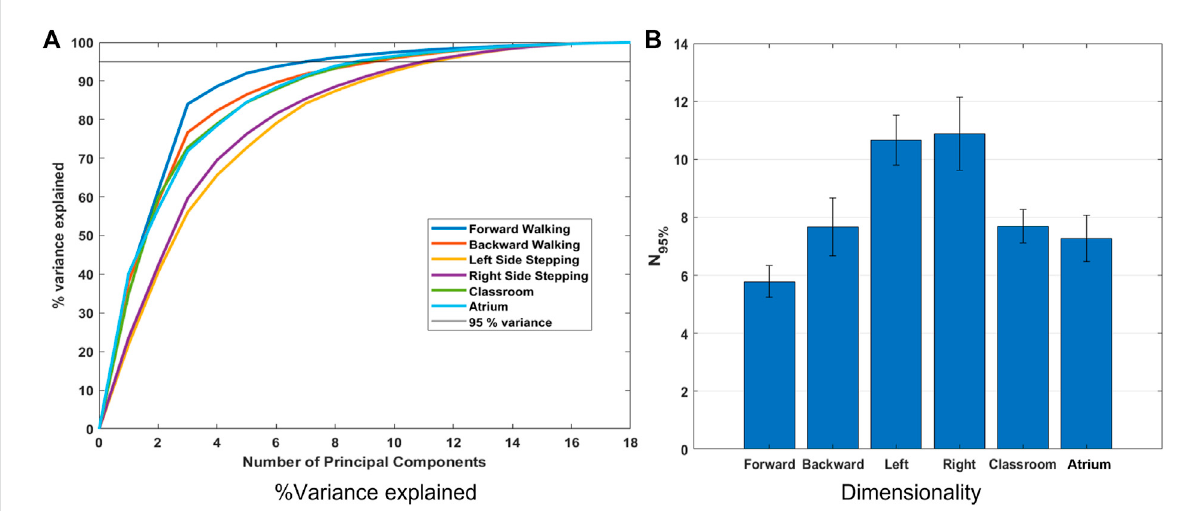
activities. Forward walking shows the smallest generalized